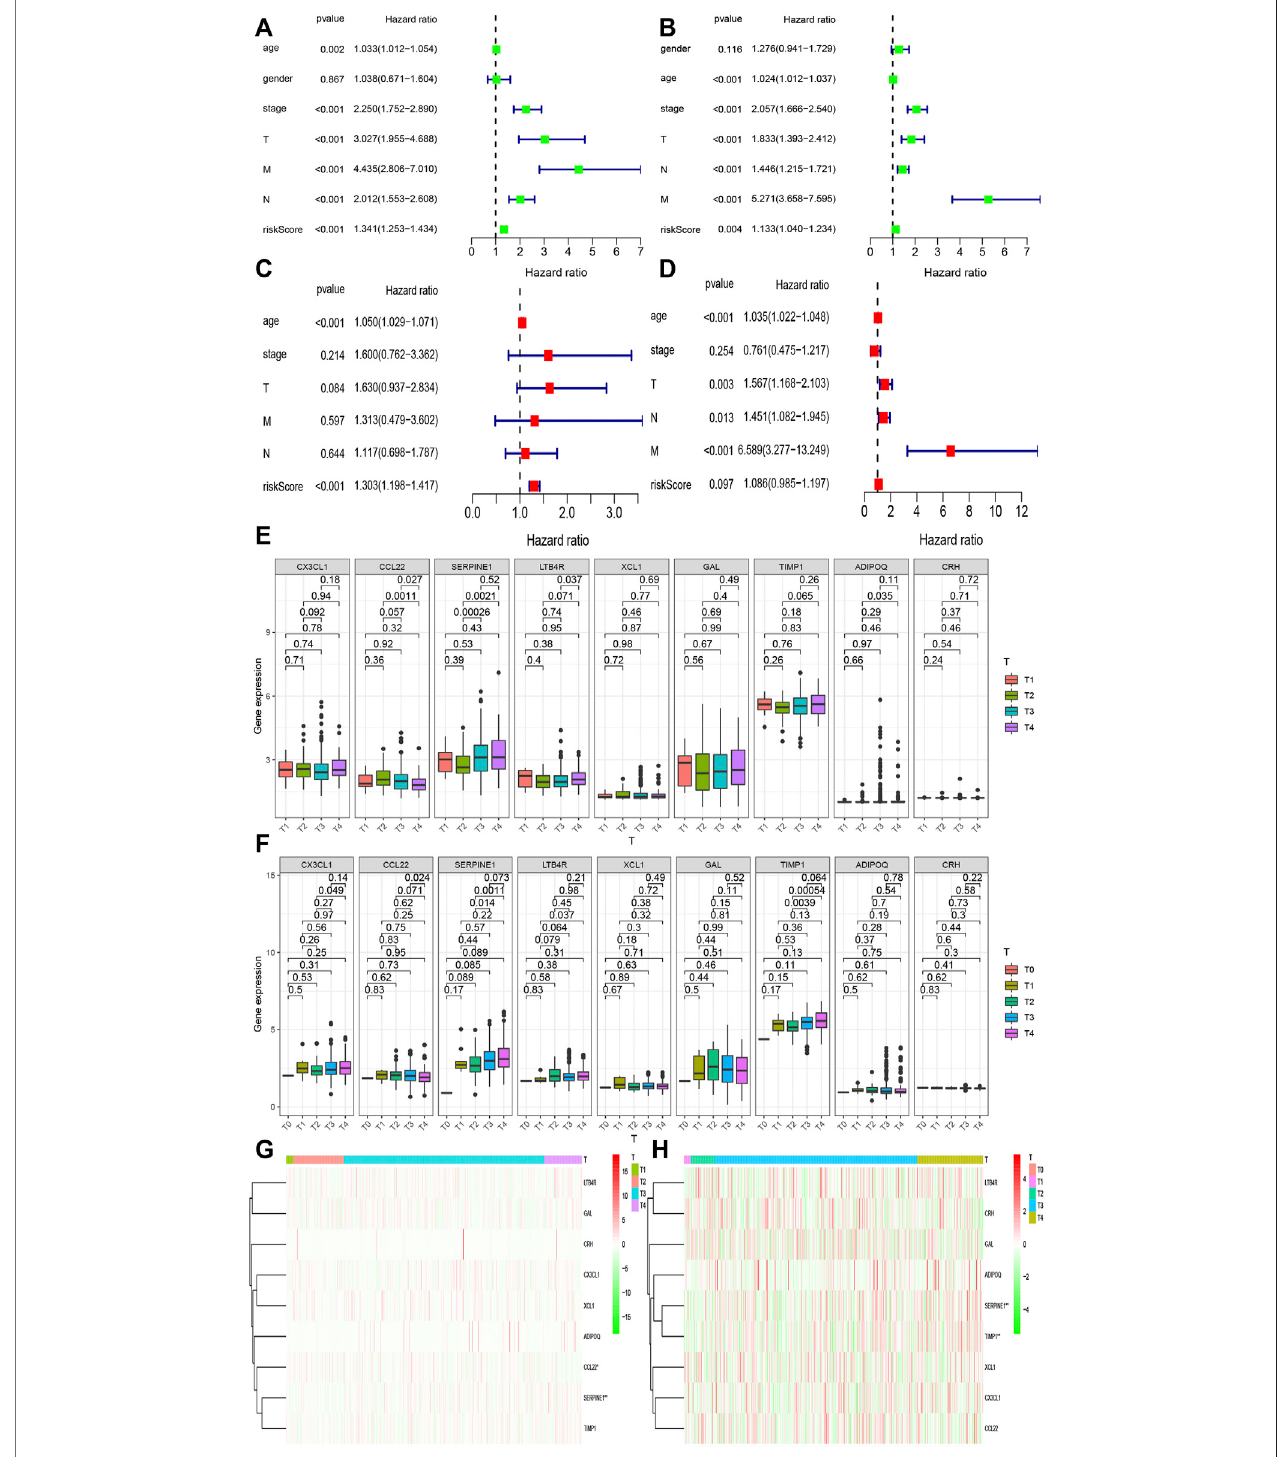
FIGURE4| Relationshipbetweentheriskmodelanddifferentclinicaltraits. (A,B) Univariateprognosticanalysiswasperformedonage,sex,T,N,Mstage,andrisk score ofcolorectal cancer patients in the TCGA and GEOdatabases. (C,D) Multivariate prognostic analysis was performed on age, sex, T, N, M stage, and riskscore of colorectalcancerpatientsinthe TCGA and GEO databases. (E,F) Expressionofgenesbetween among Tstages in theTCGA and GEO databases. (G,H) Heat maps of the expression of in fl ammatory response genes among different T stages in models in the TCGA and GEO databases.